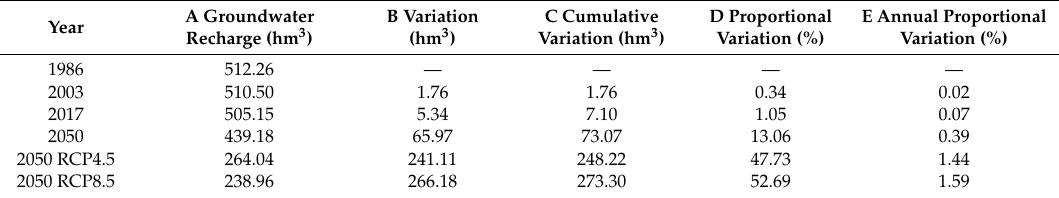
Table 8. Temperature and precipitation for the municipality of Acapulco [48].